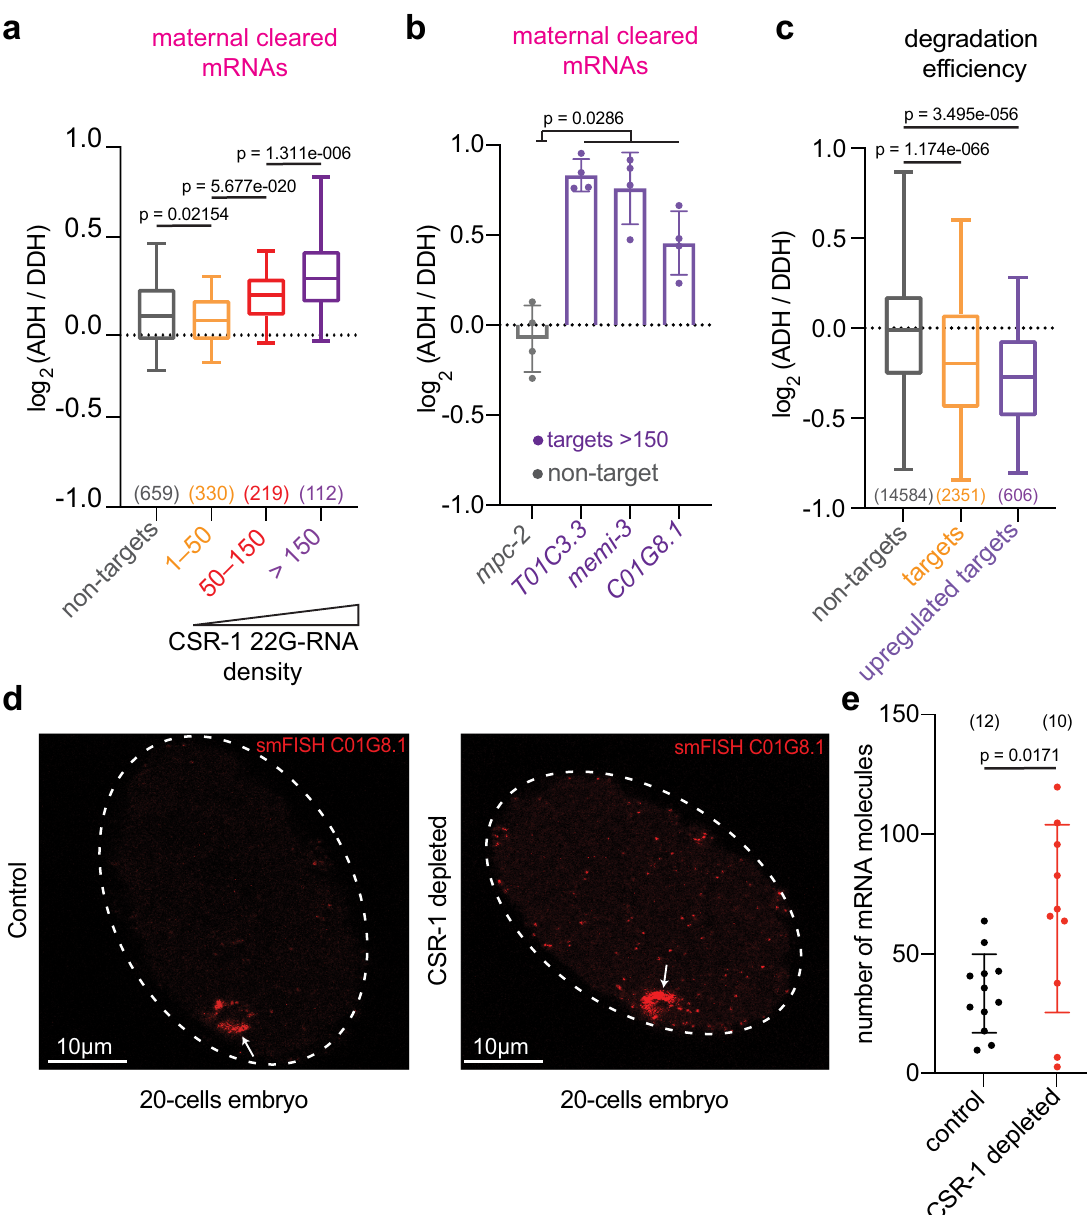
Fig. 4 CSR-1 cleaves maternal mRNAs in early embryos. a Box plots showing the log 2 fold change of cleared maternal mRNAs in CSR-1-depleted early embryos rescued with transgenic expression of CSR-1 ADH (catalytic dead) or CSR-1 DDH (catalytic active) for gene sets of increasing 22G RNA density, 1 – 50 RPM, 50 – 150 RPM, >150 RPM or non-target genes. The line indicates the median value, the box indicates the fi rst and third quartiles, and the whiskers indicate the 5th and 95th percentiles, excluding outliers. The sample size n (genes) is indicated in parentheses. b RT-qPCR showing log 2 fold change of maternal cleared mRNAs in CSR-1-depleted embryos with transgenic expression of CSR-1 with (ADH) or without (DDH) mutation in the catalytic domain. Data are presented as mean ± SD from four biologically independent replicates. c Box plots showing the log 2 fold change of the degradation ef fi ciency in CSR-1-depleted early embryos rescued with transgenic expression of CSR-1 ADH versus CSR-1 DDH. The degradation ef fi ciency was calculated by the ratio of normalized degradome-seq reads versus RNA-seq reads. The line indicates the median value, the box indicates the fi rst and third quartiles, and the whiskers indicate the 5th and 95th percentiles, excluding outliers. The sample size n (genes) is indicated in parentheses. Genes with 0 counts in RNA-seq (ADH/DDH) have been excluded from calculation. “ Upregulated targets ” = CSR-1 targets with log2FC (ADH/DDH) > 0 and adjusted P value <0.05 by RNA-seq. d Representative images of C01G8.1 mRNA smFISH in control (left) and CSR-1 depleted (right) 20-cell stage embryos. Arrows indicates the accumulation of mRNAs in germline blastomere. e smFISH quanti fi cation of C01G8.1 mRNA (embryonic CSR-1 target) in somatic blastomeres of control (black) and CSR-1 depleted (red) 20-cell stage embryos. Data are presented as mean ± SD and the dots are the number of mRNA molecules per embryo section. The sample size n (embryos) is indicated in parentheses. Scale bars represent 10 µ m. In a , b , c , e , two-tailed P values were calculated using Mann – Whitney – Wilcoxon tests. Source data are available